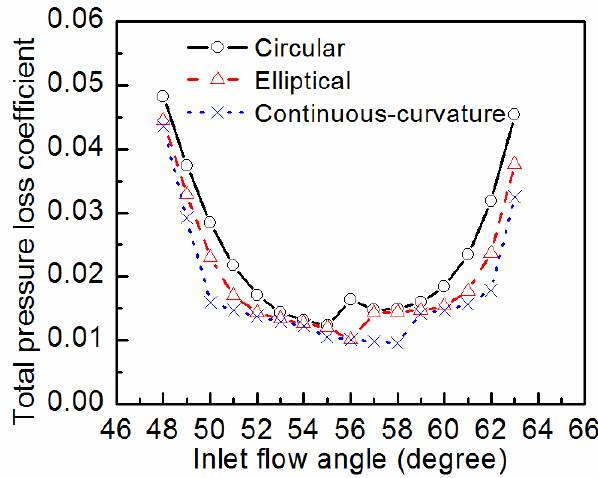
Figure 10. Loss buckets of blades with different leading-edge shapes.